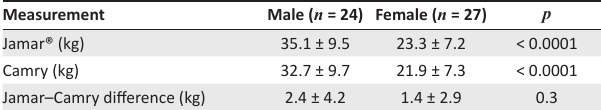
FIGURE 2: Bland–Altman plot of Jamar versus Camry measurements. TABLE 2: Handgrip strength according to